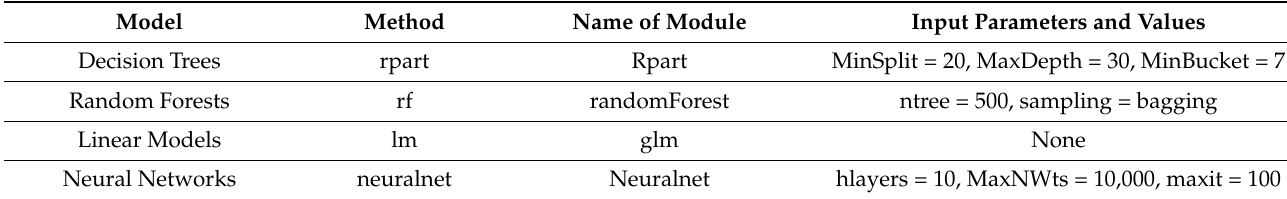
Table 2. Machine Learning Methods Used